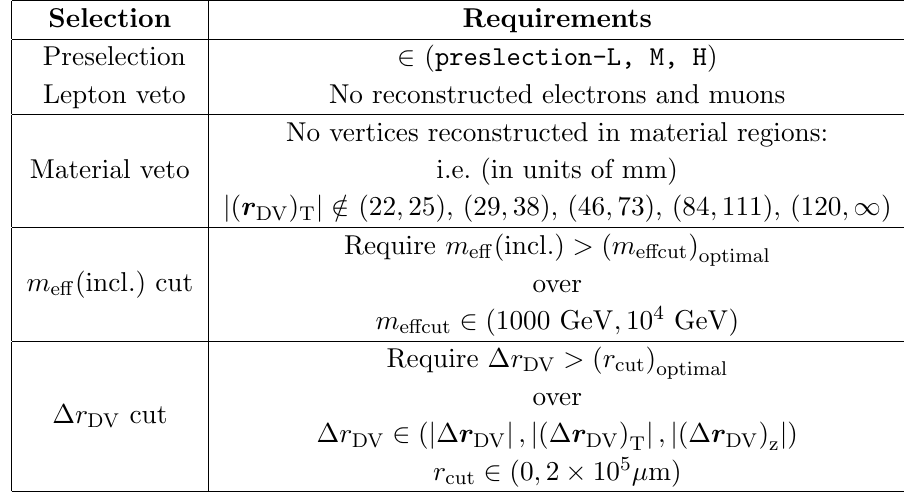
Table 6. Summary of event selection